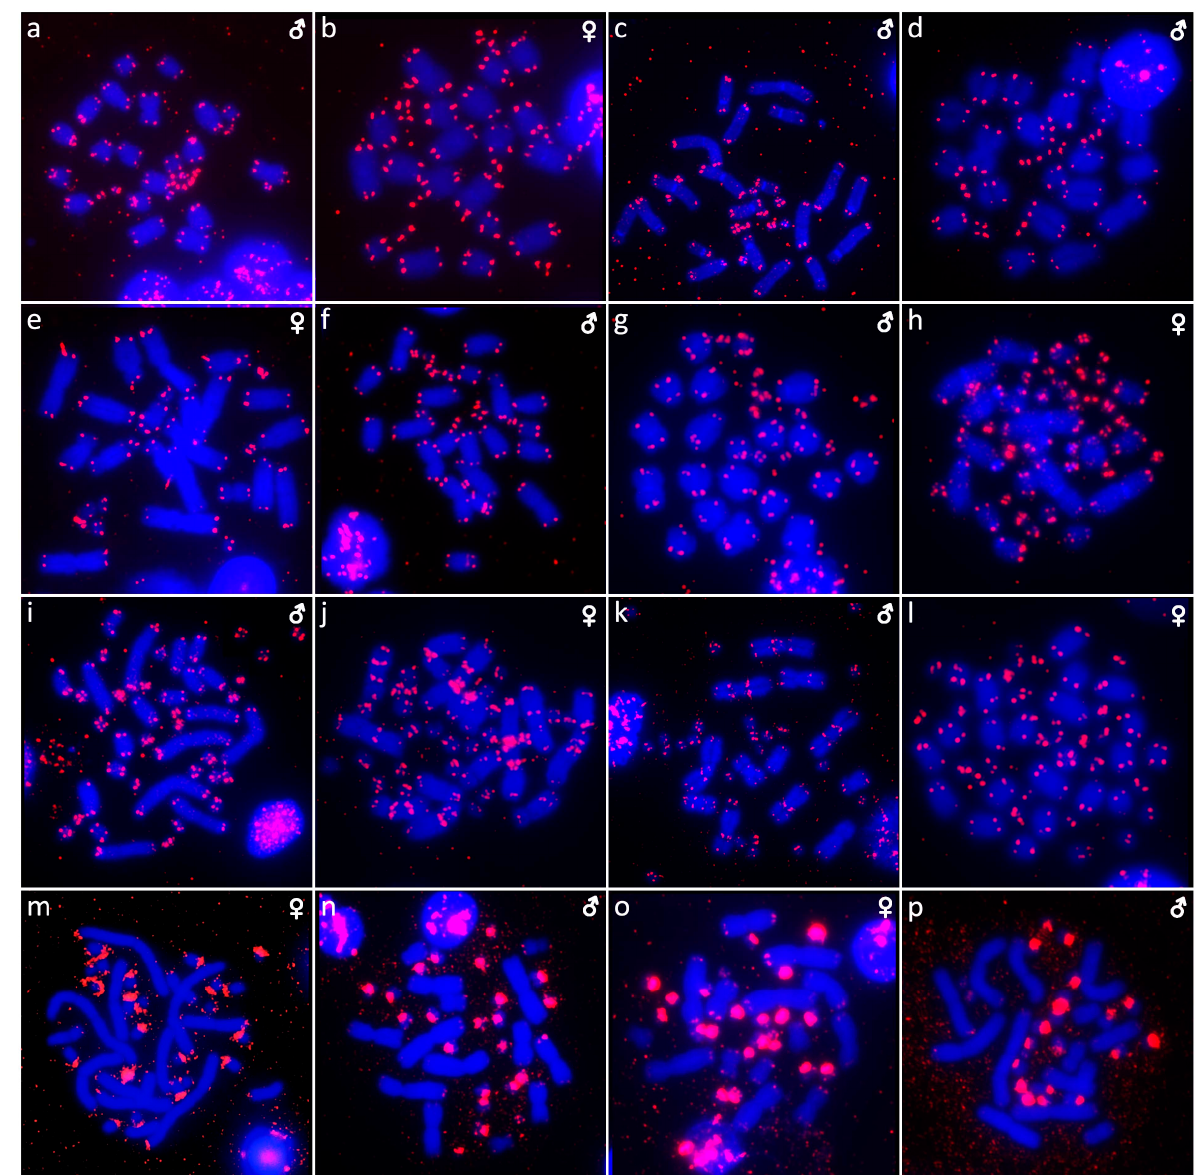
Figure 6. In situ hybridization with probe for telomeric sequences in Abronia campbelli ( a ), Abronia deppii ( b , c ), Abronia graminea ( d ), Abronia lythrochila ( e , f ), Abronia mixteca ( g ), Barisia rudicollis ( h , i ), Celestus warreni ( j , k ), Gerrhonotus liocephalus ( l ), Heloderma exasperatum ( m , n ) and Heloderma horridum ( o , p ).